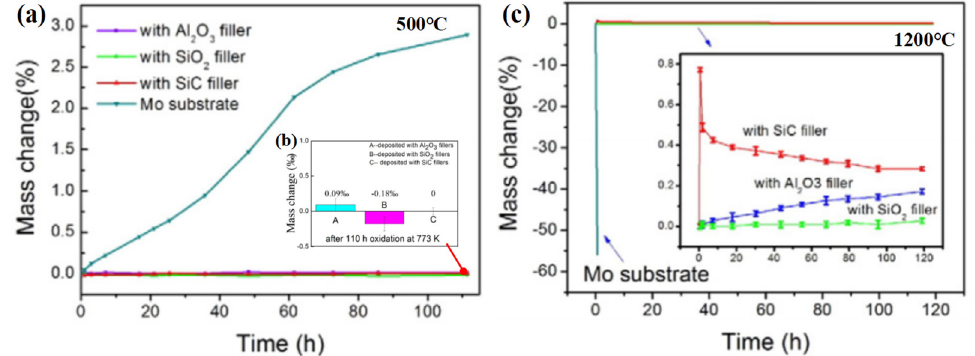
Figure 5. The oxidation kinetics in terms of time of exposure as well as temperature of Mo substrate and coatings at different temperatures, ( a ) 500 °C, ( b ) is the local amplification at 110 h as shown in ( a , c ) 1200 °C. Reprinted with permission from [30]; Reproduced from (Sun et al., 2016).